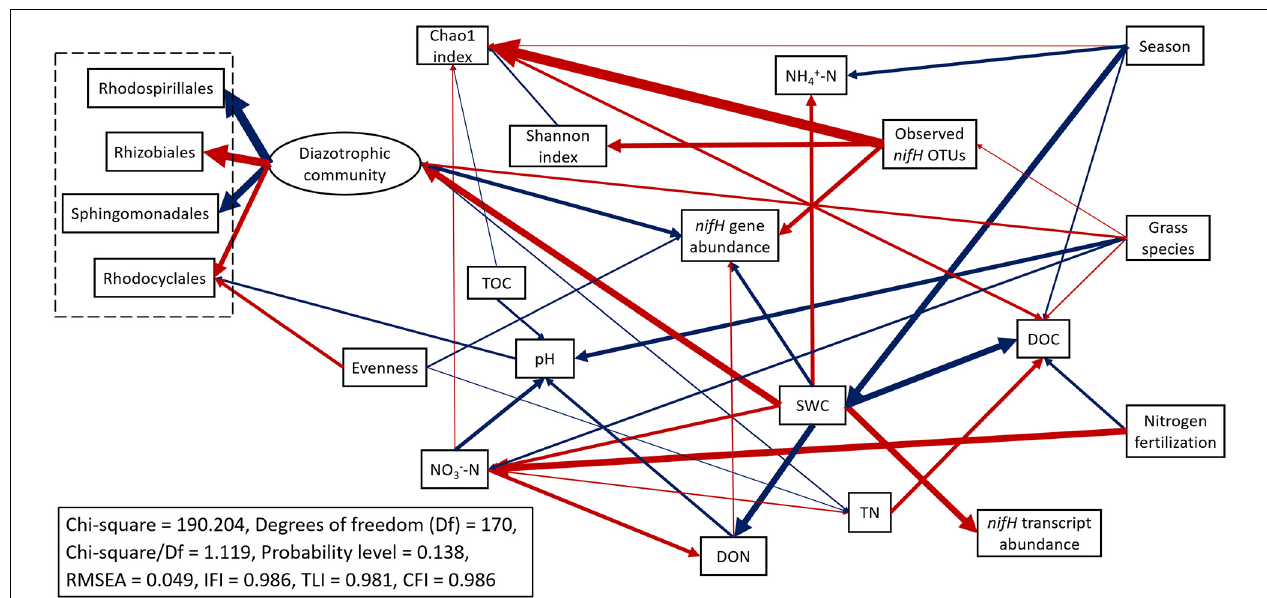
FIGURE 8 | Structural equation modeling (SEM) of diazotrophic microbial abundance, functional activity, diversity, and predominant taxa (order level) with key soil parameters. Boxes represent observable variables. An ellipse represents the latent variable of community composition, which was inferred from the measured relative abundances of taxa in the community (dashed box). The four orders shown were selected because they had significant associations with the other factors in the model. Season refers to sampling time (grass green up, first harvest or second harvest). Red arrows indicate positive relationships. Blue arrows indicate negative relationships. Single headed arrows represent causal relationship ( p -value < 0.05). The direction of arrow indicates the direction of causation. The width of arrow indicates the extent of effects, i.e., the standardized path coefficients proportional to the thickness of arrows. See Supplementary Table 6 for specific standardized path coefficients and Supplementary Table 7 for standardized total effects. SWC, soil water content; DOC, dissolved organic C; DON, dissolved organic N; TOC, total organic C; TN, total